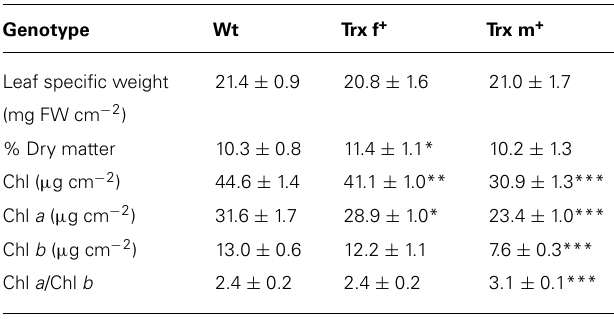
Table 1 | Leaf specific weight, dry matter percentage and chlorophyll content in 40-day oldWt and transplastomic tobacco plants.